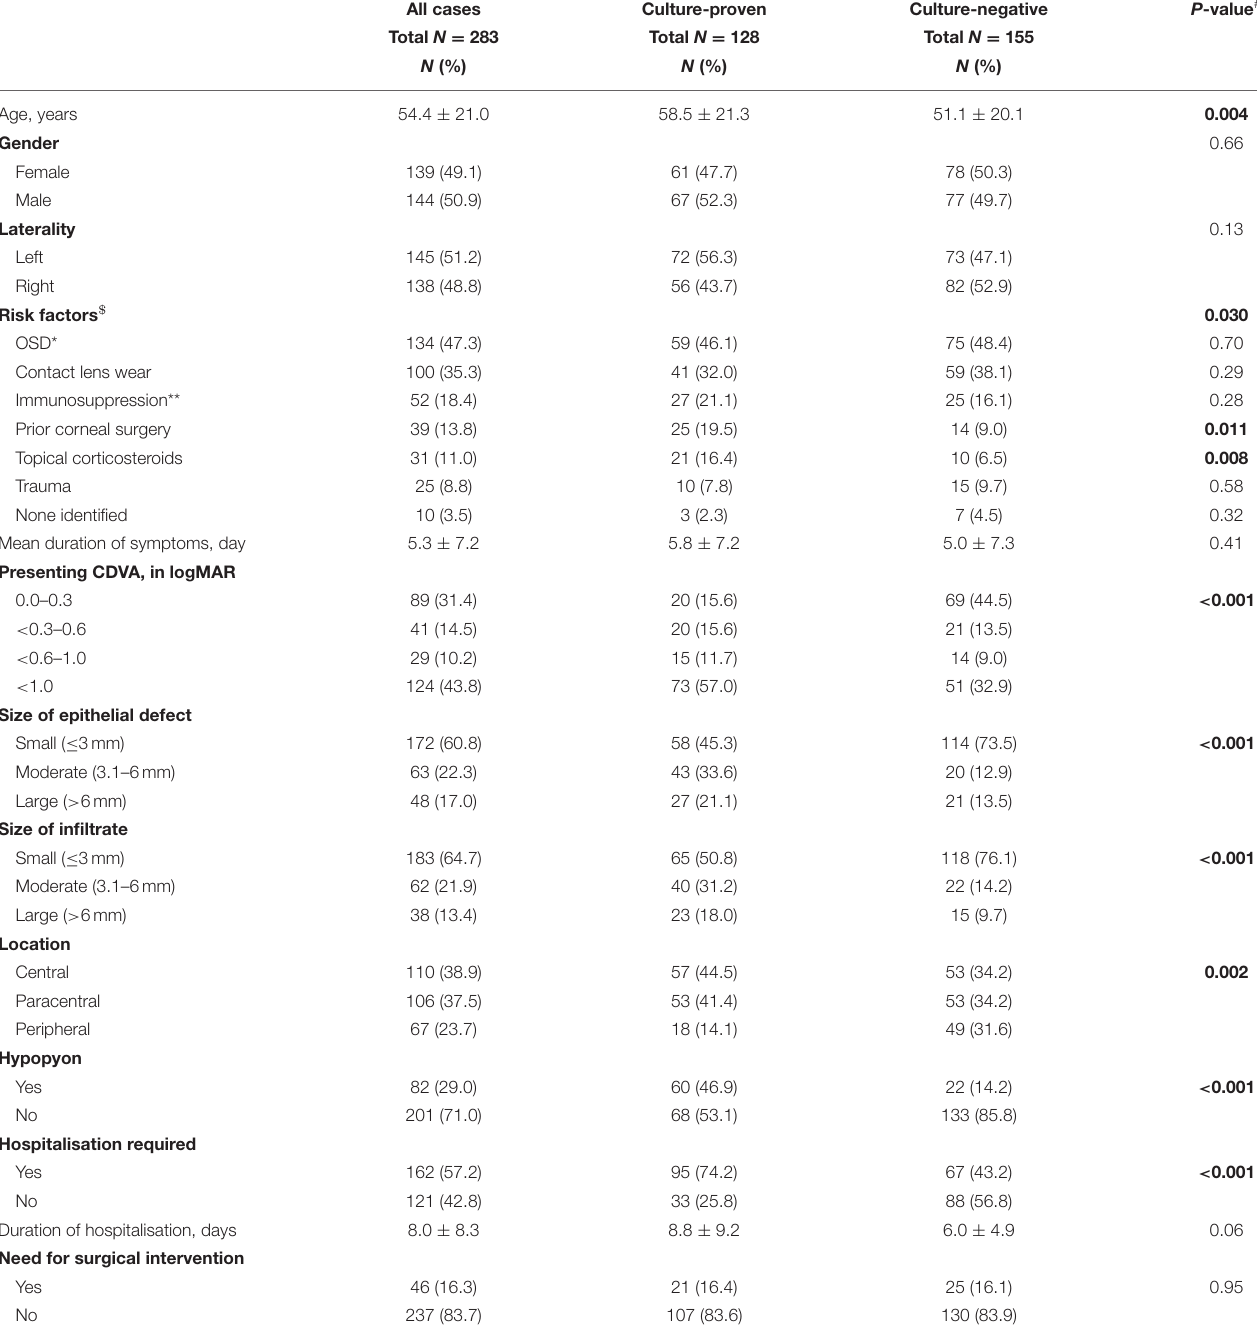
TABLE 1 | Summary of the demographic factors, risk factors, and baseline clinical characteristics of bacterial keratitis presented to Queen’s Medical Centre, Nottingham, UK. All cases